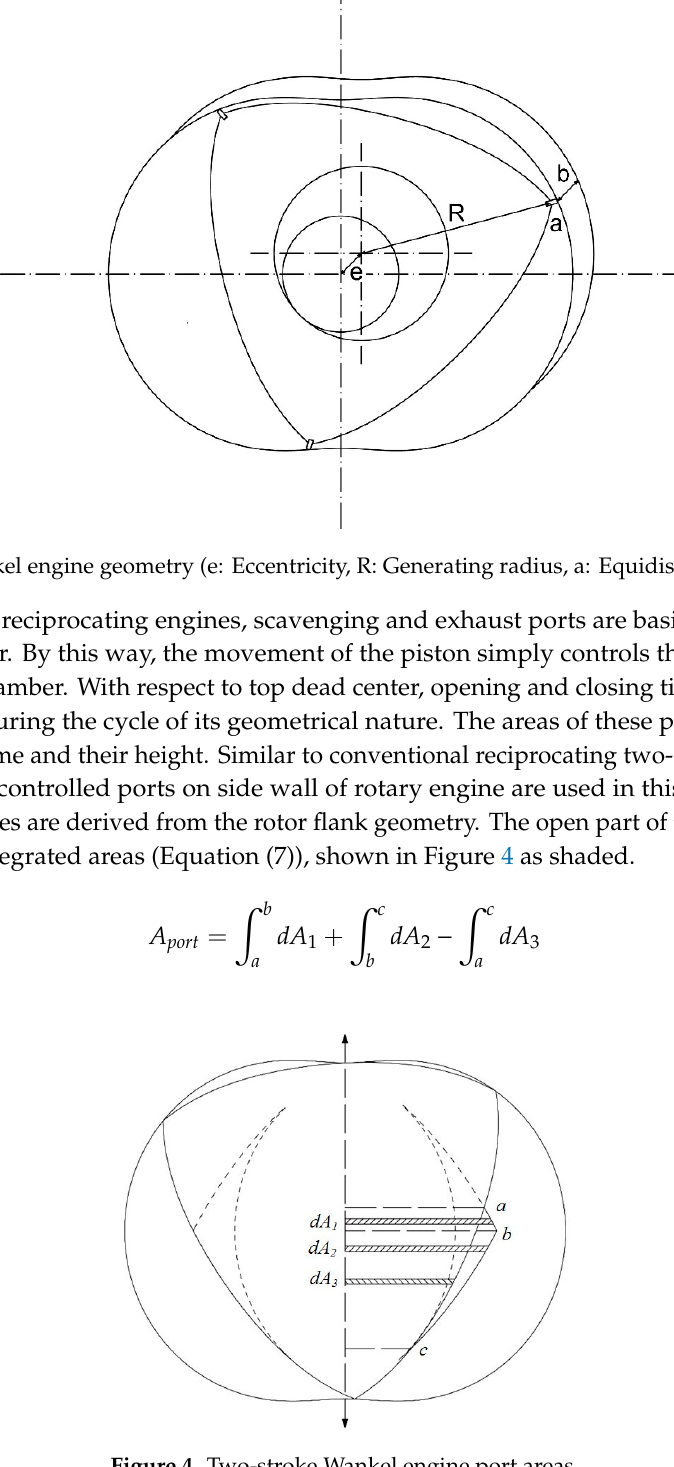
Figure 4. Two-stroke Wankel engine port areas.